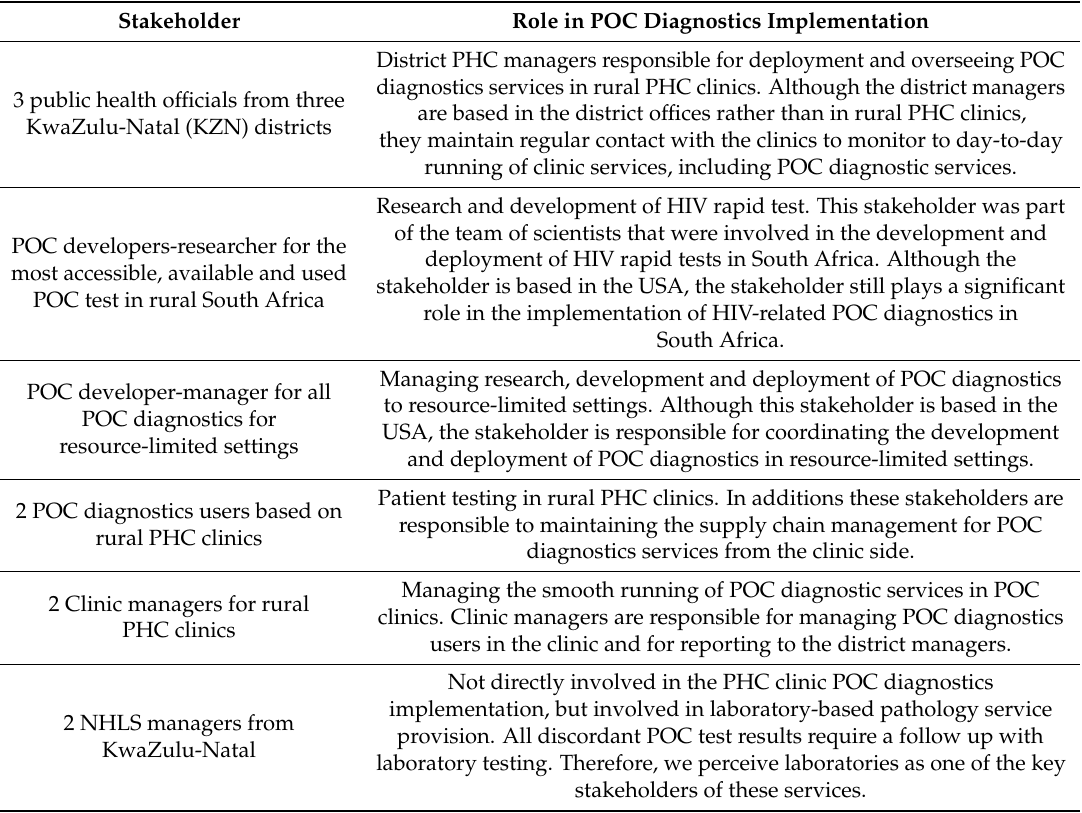
Table 2. Stakeholder involvement in POC implementation for rural primary healthcare (PHC) clinics in South